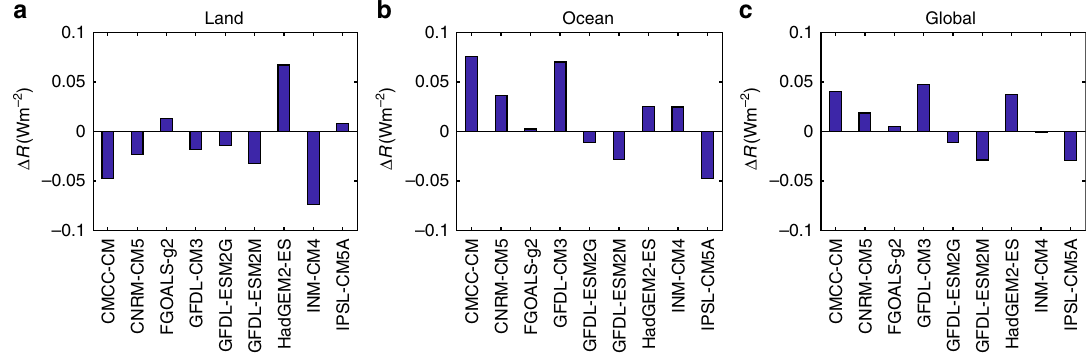
Fig. 5 Change in reference irradiance in response to climate change. Change of TOA reference irradiance over a land, b ocean, and c whole Earth